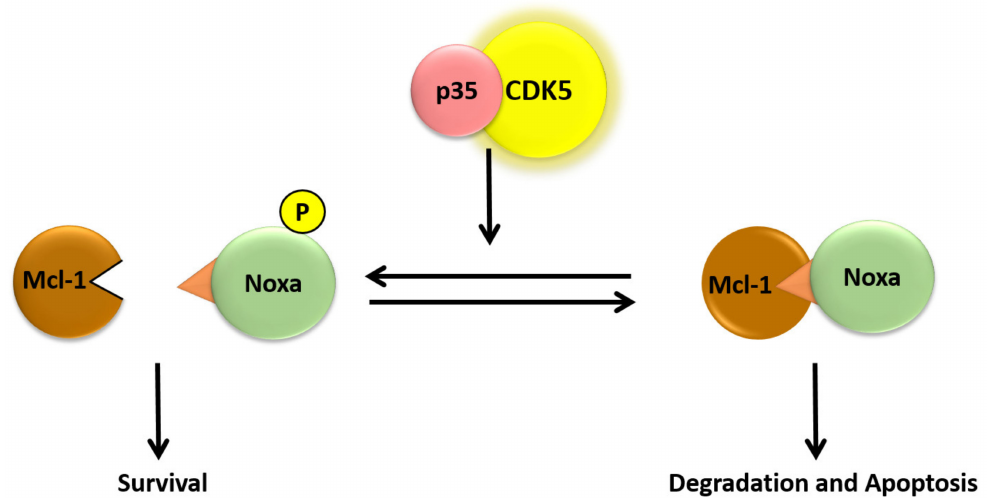
Figure 4. Hypothetical model for the role of Noxa serine-13 phosphorylation on induced